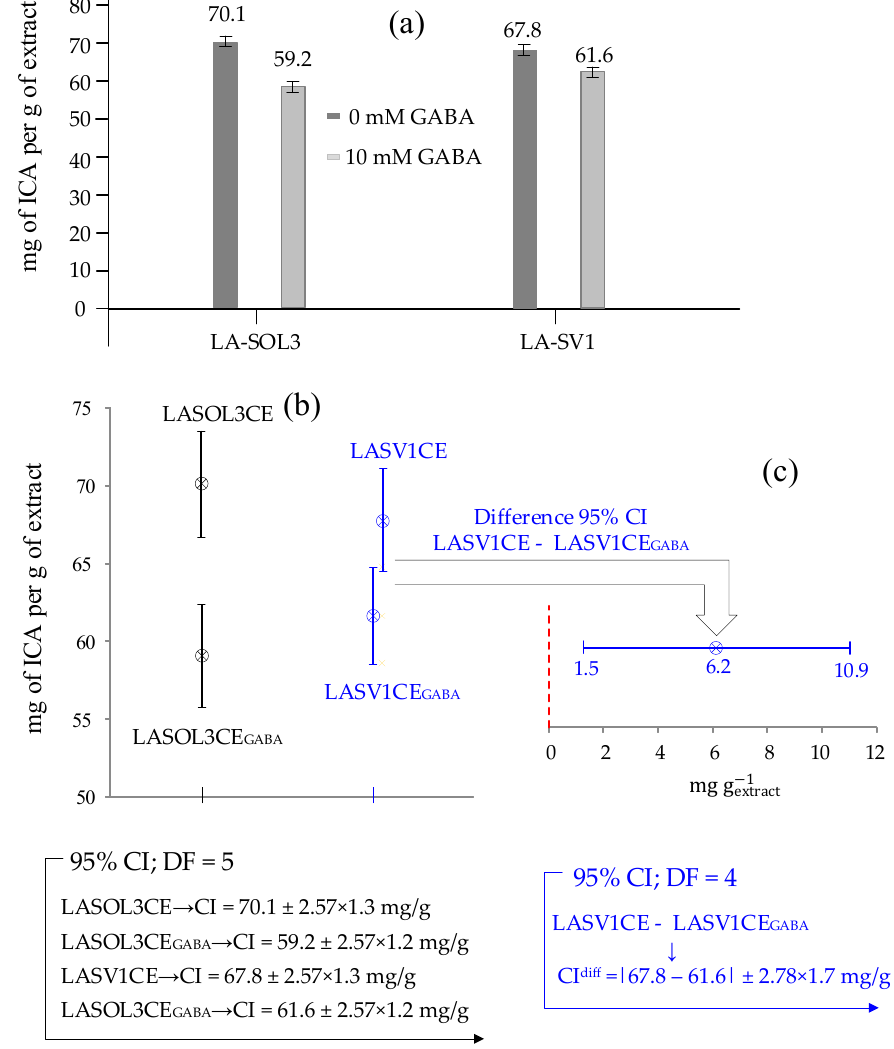
Figure 6. ( a ) Concentrations, C , and standard deviations, s C (expressed as mg per g of extract) of indole-3-carboxylic acid (ICA, 1 ) in crude extracts of Lasiodiplodia theobromae LA-SOL3 and LA-SV1 grown in the presence (10 mM) and absence of γ -aminobutyric acid (GABA) (i.e., LA-SOL3CE, LA-SOL3CE GABA , LA-SV1CE and LA-SV1CE GABA ). ( b ) Here, 95% Confidence Interval about ICA concentrations in ( a ), and ( c ) 95% CI about the difference of ICA concentrations in LA-SV1CE e LA-SV1CE GABA .